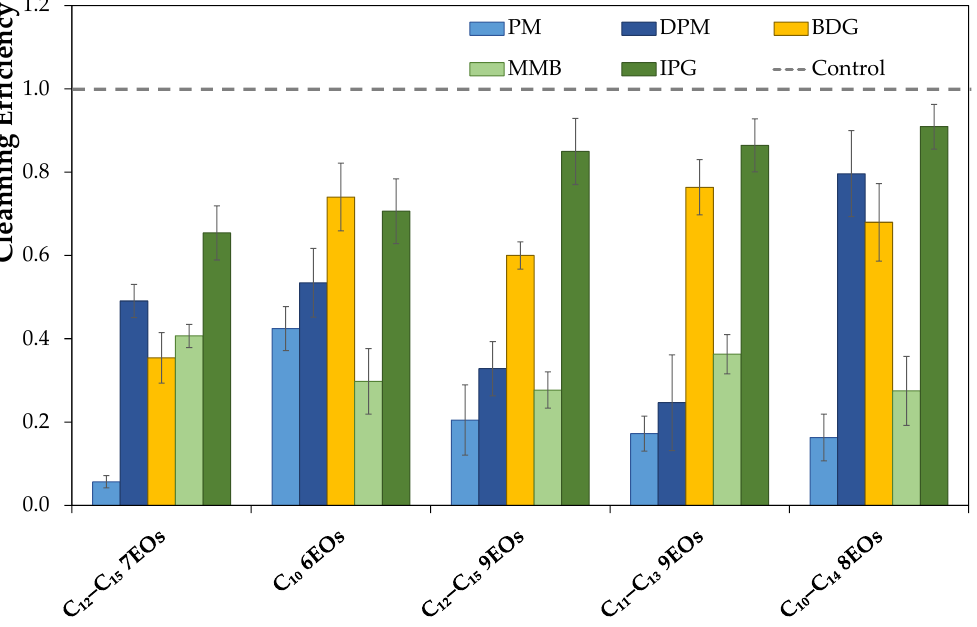
Figure 3. Cleaning efficiency of formulations with nonionic surfactants in ceramic tiles obtained by abrasion scrub test: bars represent the cleaning efficiency of the formulation with different solvents, and error bars are the standard deviation (between 1% and 11%) of at least five independent measurements.